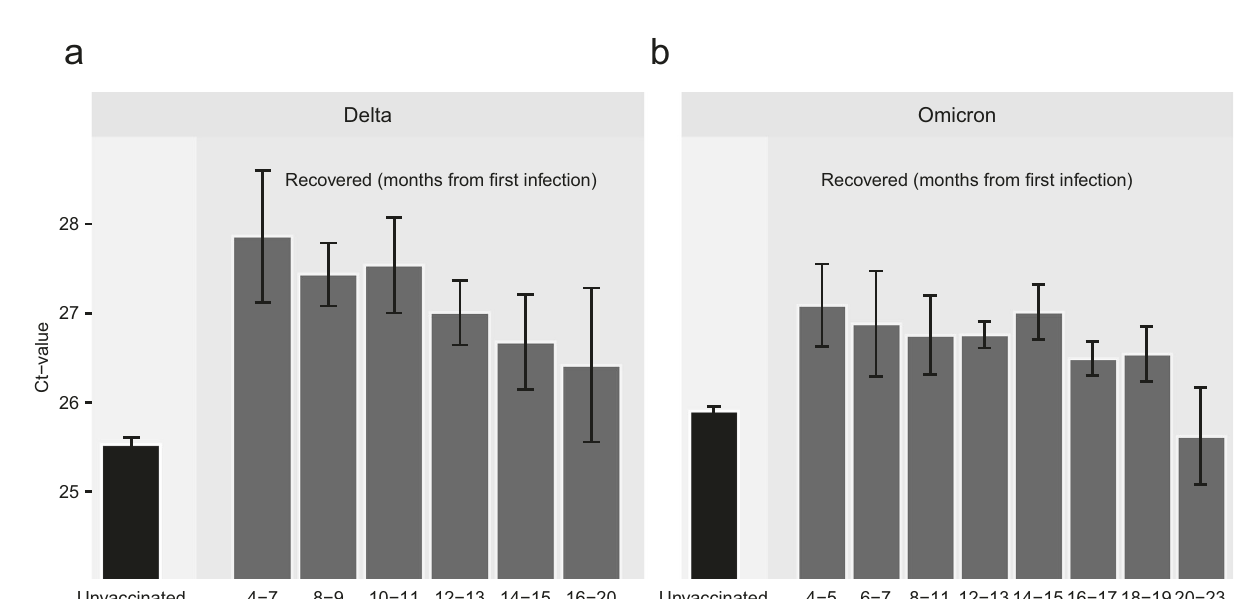
Fig. 3 | Ct values of the gene N for recovered, unvaccinated, individuals parti- tioned by number of months after recovery, for the Delta (a, n =48,513 inde- pendent samples) and Omicron ( b , n=53,565 independent samples) variants. Meanswereobtainedfromtheweightedsumofage,sexandcalendartime,andthe